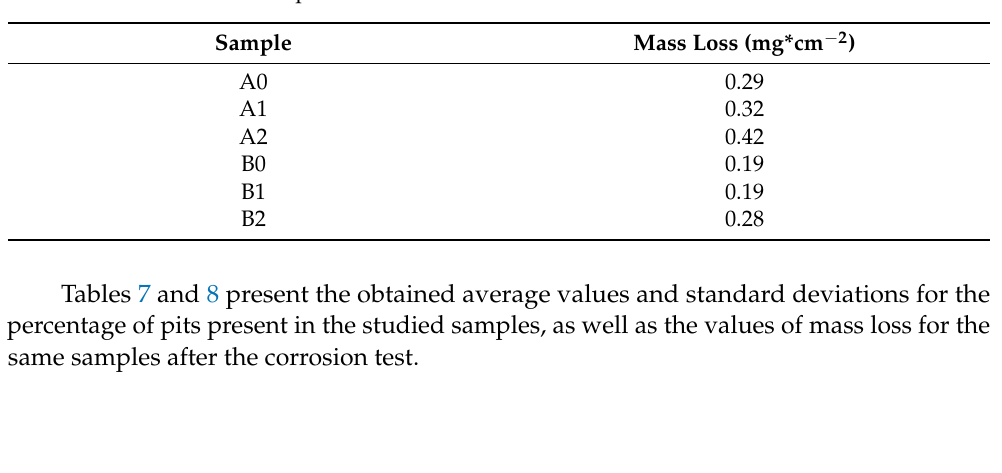
Figure 6. SEM micrographs of the studied samples: A0 with secondary electrons at a magnification of × 1347 ( a ), A1 with backscattered electrons at a magnification of × 1356 ( b ), A2 with secondary electrons at a magnification of × 1600 ( c ), B0 with backscattered electrons at a magnification of × 1600 ( d ), B1 with secondary electrons at a magnification of × 1332, and ( e ) B2 with backscattered electrons at a magnification of × 1600 ( f ). Table 8. Mass loss of the samples submitted to the corrosion